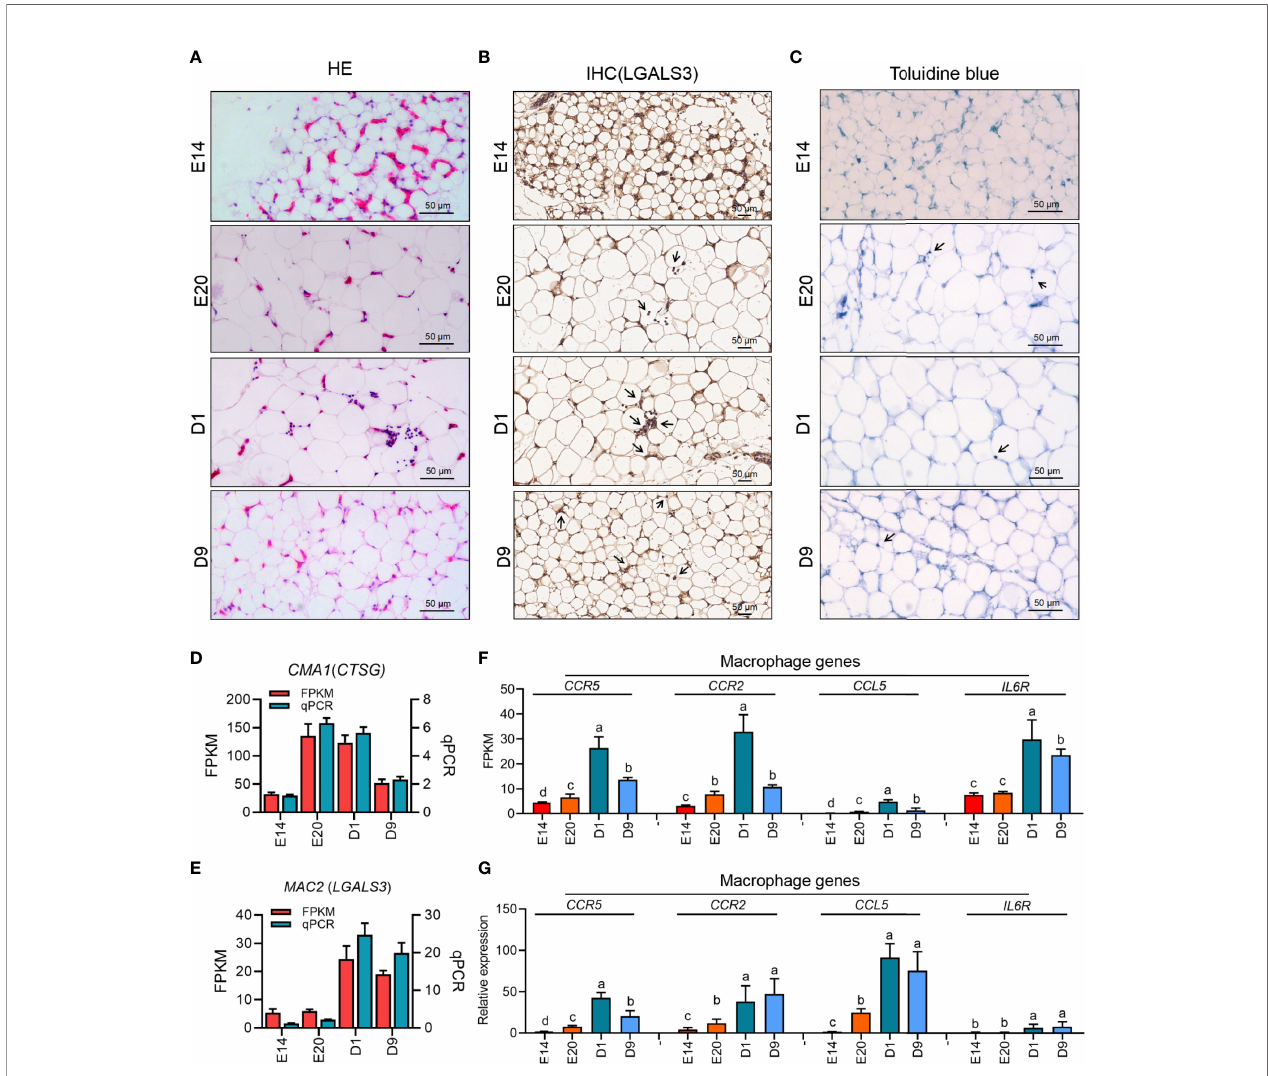
FIGURE 9 | Immune in fi ltration of four development stages of subcutaneous adipose tissue in chicken. (A – C) HE staining, IHC staining (LGALS3), and toluidine blue staining of chick subcutaneous adipose tissue in four development stages; (D, E) the expression of mast cell ( CMA1 ) and macrophage ( MAC2 ) marker genes of chick subcutaneous adipose tissue in four development stages; (F) FPKM of macrophage-related genes of chick subcutaneous adipose tissue in four development stages; (G) qPCR of macrophage-related genes of chick subcutaneous adipose tissue in four development